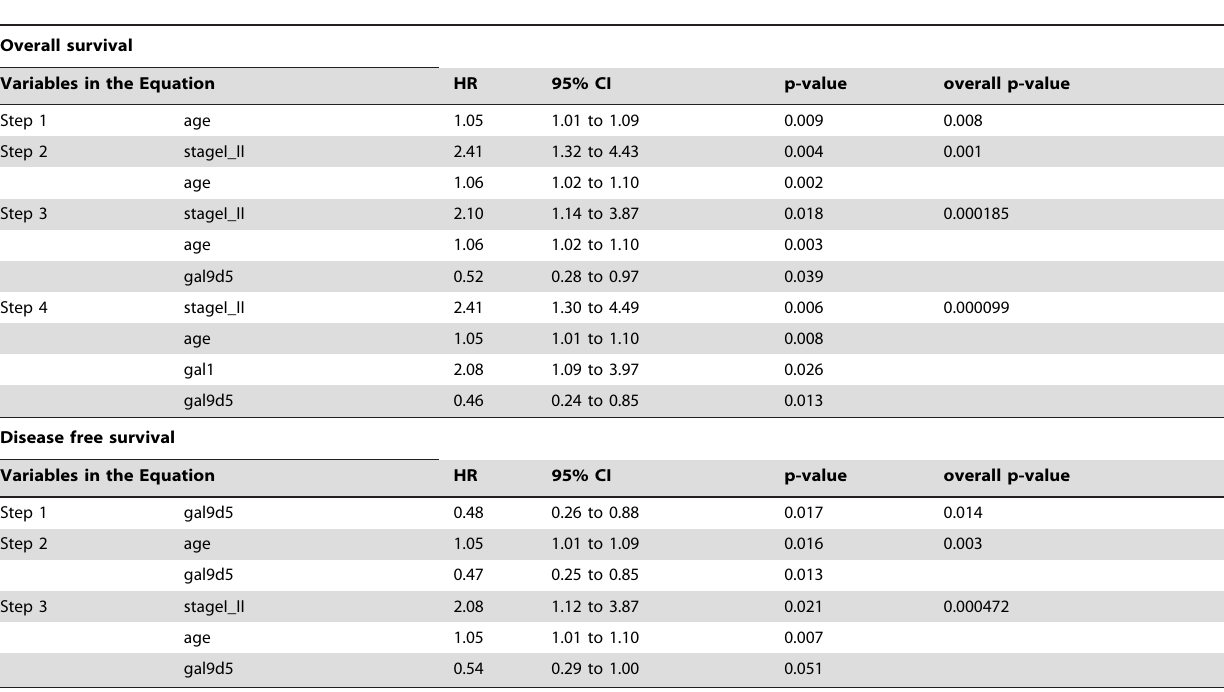
Table 5. Multivariate Cox regression analysis with forward